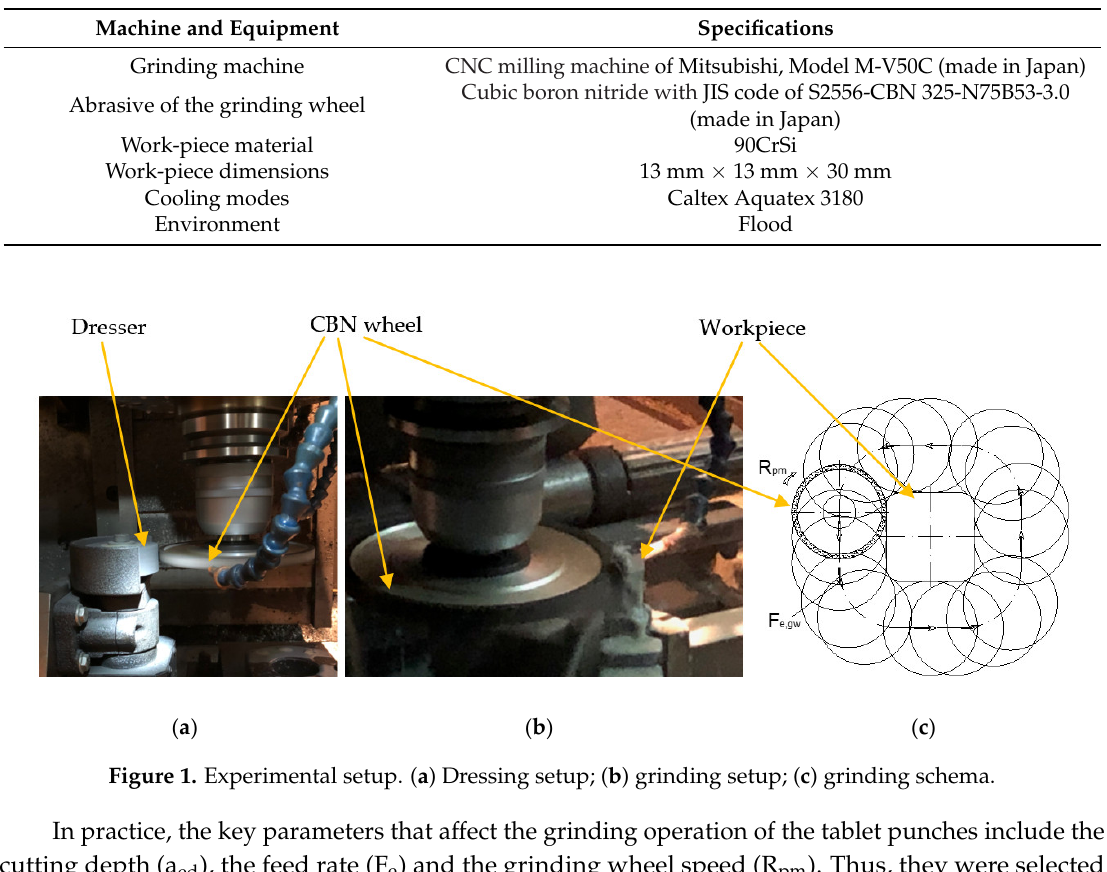
Table 1. Grinding conditions for the experiment.